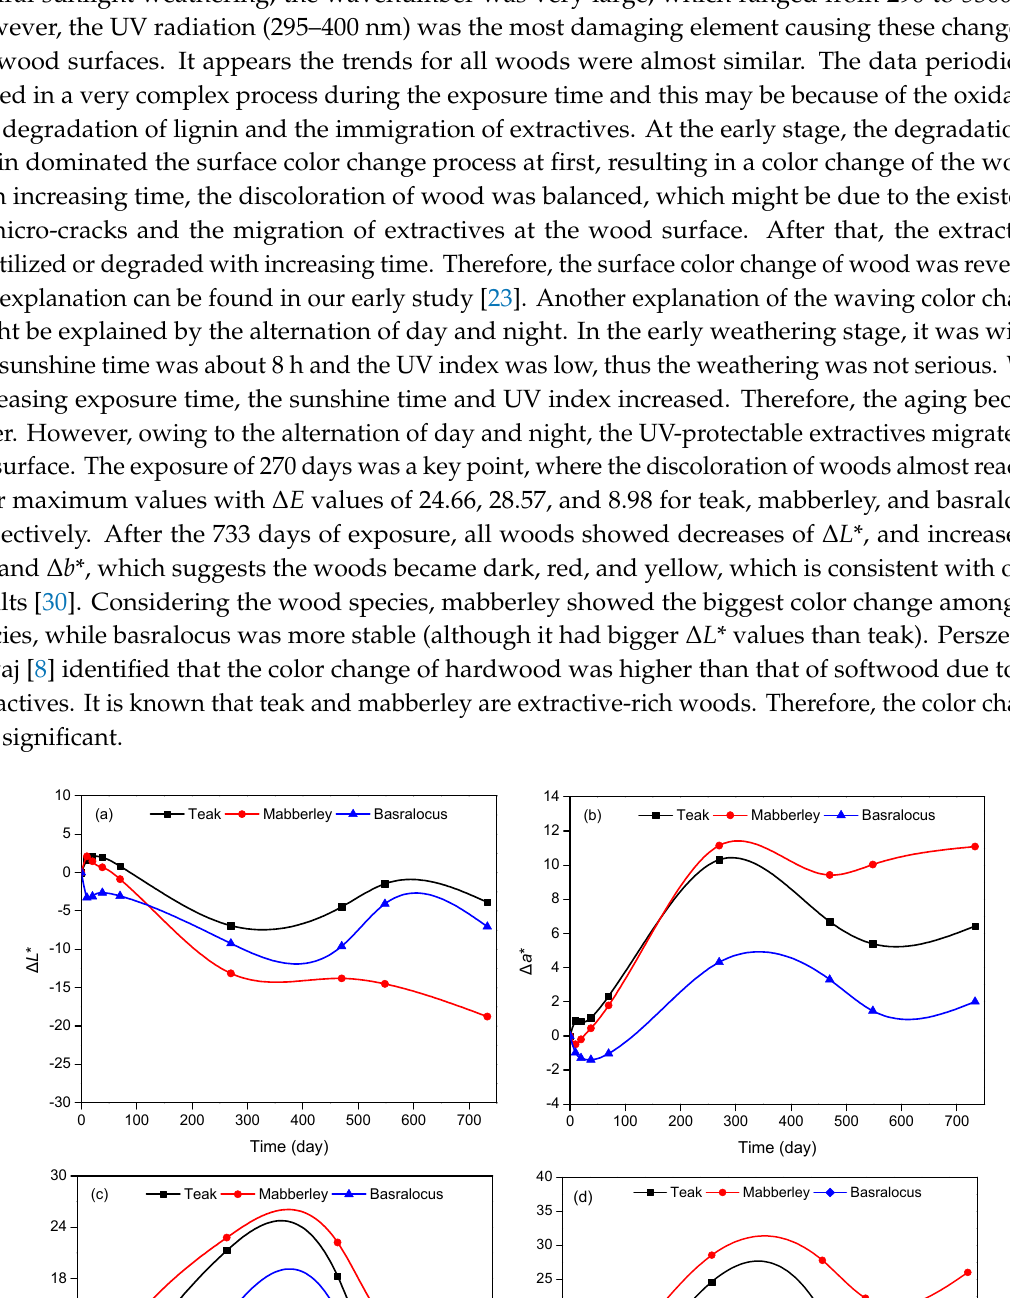
Figure 1. Surface morphologies of the three wood samples before and after aging. ( a – c ) Teak; ( d – f ) mabberley; ( g – i ) basralocus; ( a,d,g ) before aging; ( b,e,h ) after 733 days of natural sunlight aging; ( c,f,i ) after 180 h of xenon light aging.